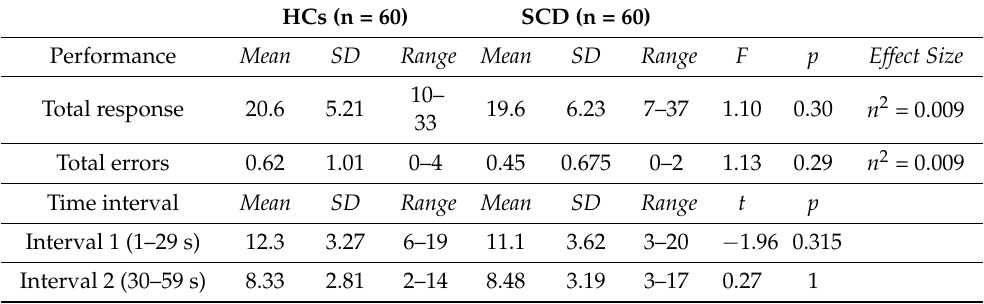
Table 2. The results on the free action fluency task according to Group, Performance and Time Interval. HCs (n =